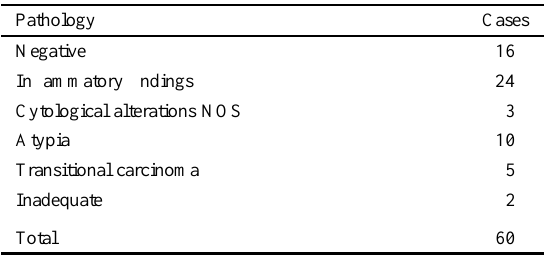
Case composition for the urinary cytology